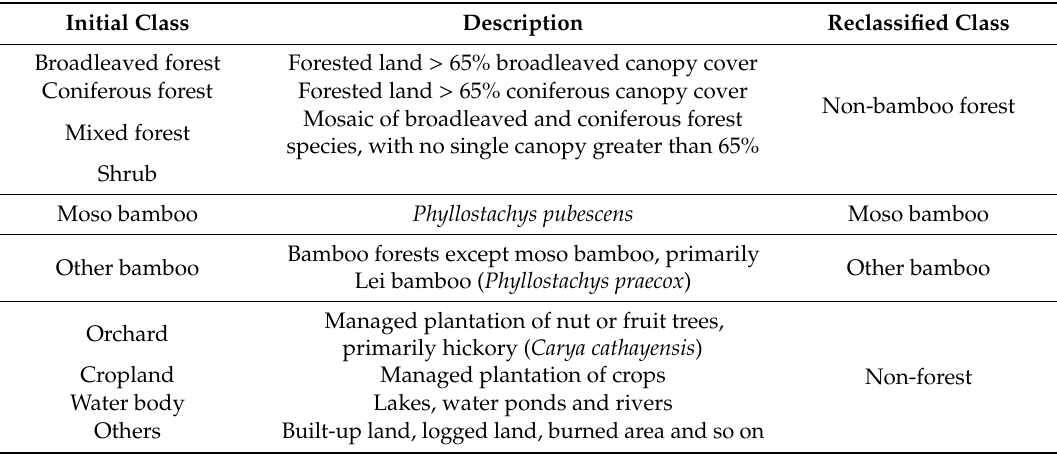
Table 1. Land cover category